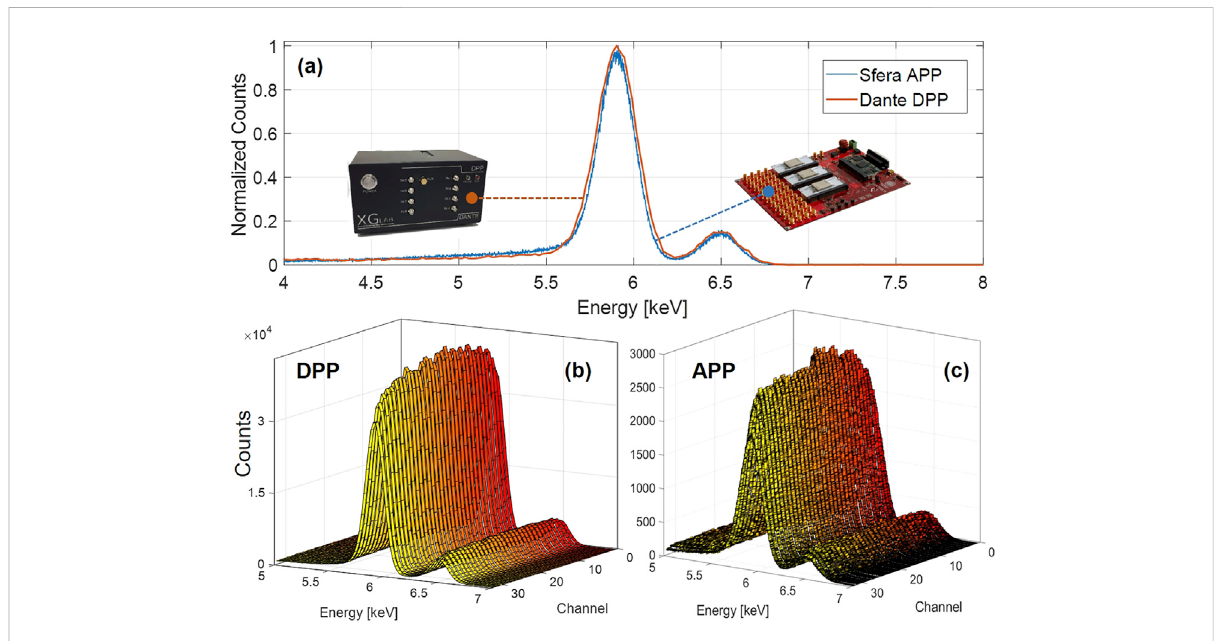
FIGURE 12 Comparison between DPP (Dante) and APP (Kerberos): simultaneous acquisition of the 32 channels with a fi ltering time of 6 µs, T = -12 ° C, L = 6 mm, p = 200 μ